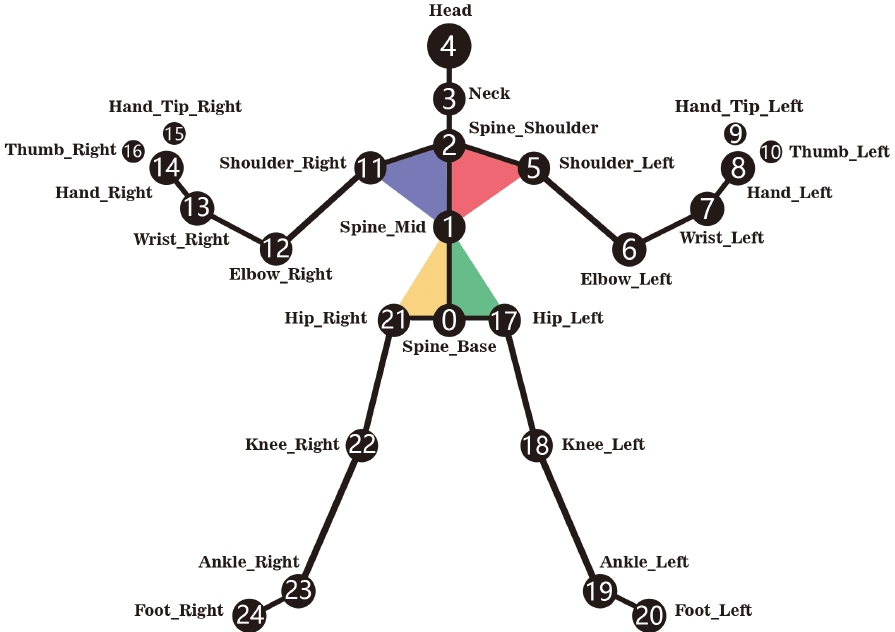
Figure 2. Names and numbers of skeleton points captured by the Kinect